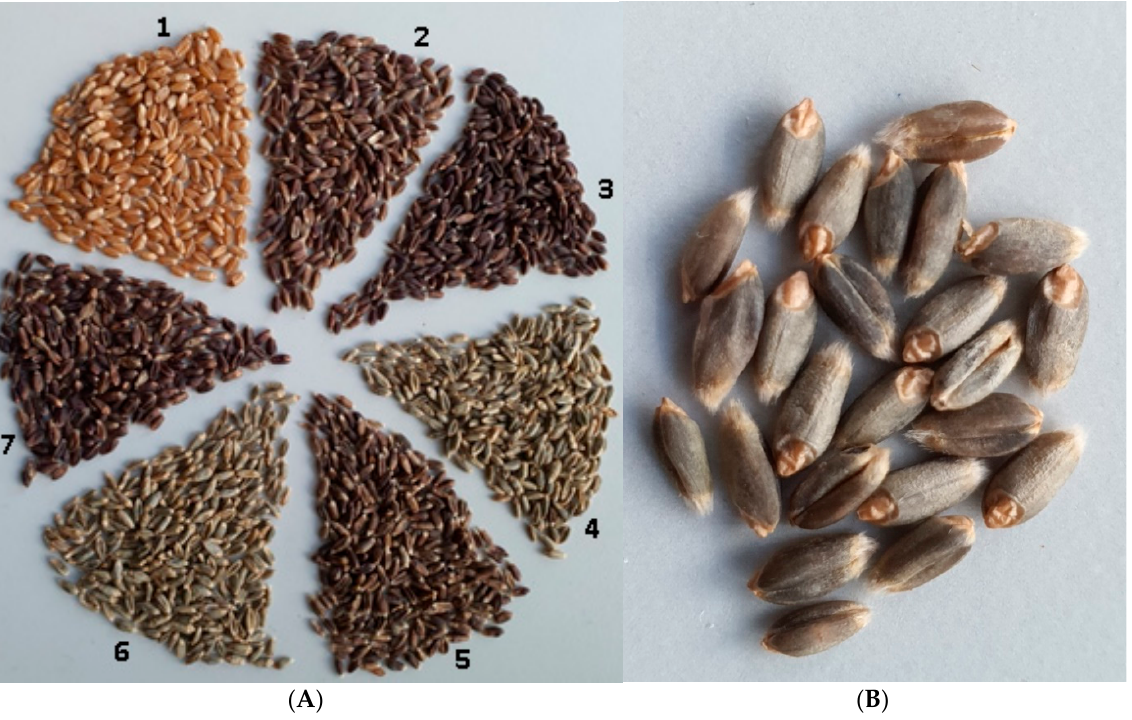
Figure 1. Diversity of colors among the analyzed wheat lines (having anthocyanin-rich grains). ( A ) The grains of the wheat lines used in this study: control line Saratovskaya 29 (S29) (1) in the upper left-hand corner and next in clockwise order S29 BLACK (4Th-4B) (2), S29 BLACK (4Th-4D) (3), S29 BLUE (4Th-4D) (4), BW BLACK (4Th-4D) (5), S29 BLUE (4Th-4B) (6), and E22 BLACK (4Th-4D) (7). ( B ) Grains of S29 BLUE (4Th-4B).